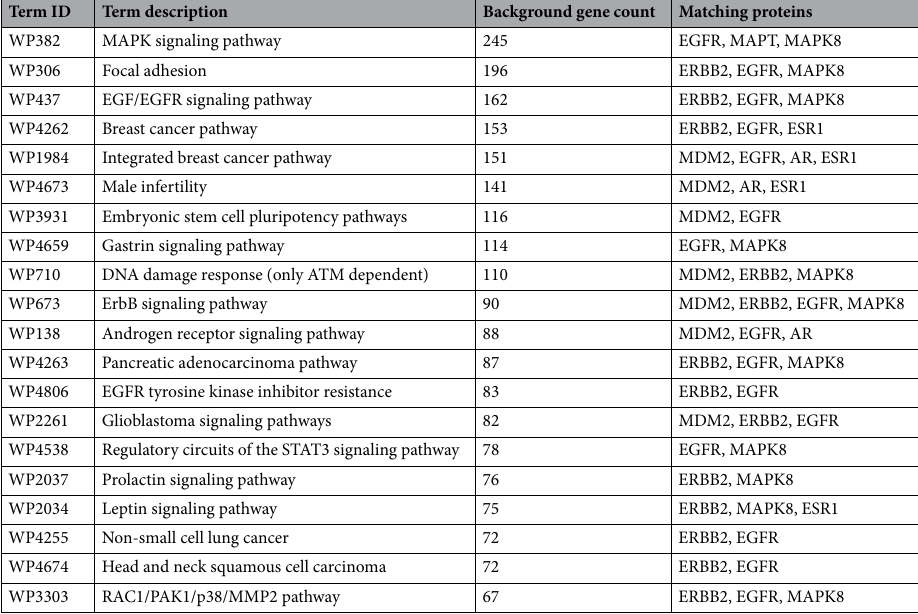
Table 3. WikiPathways analysis of core targets.